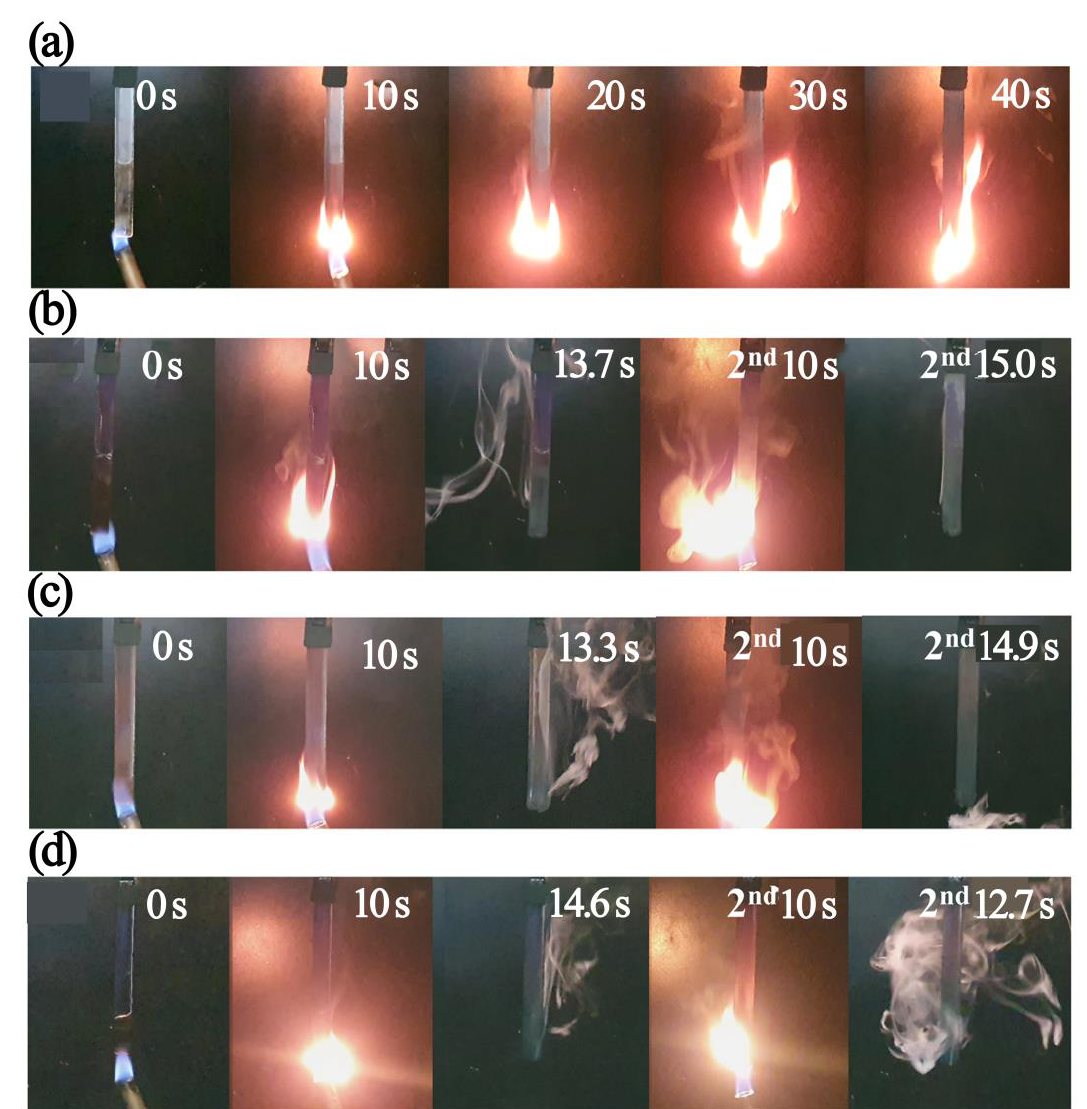
Figure 7. Digital photographs of EP ( a ), EP/EHBFR-HB 30 ( b ), EP/EHBFR-HCM 30 ( c ), and EP/EHBFR-HBM 30 ( d ) during the vertical burning test.